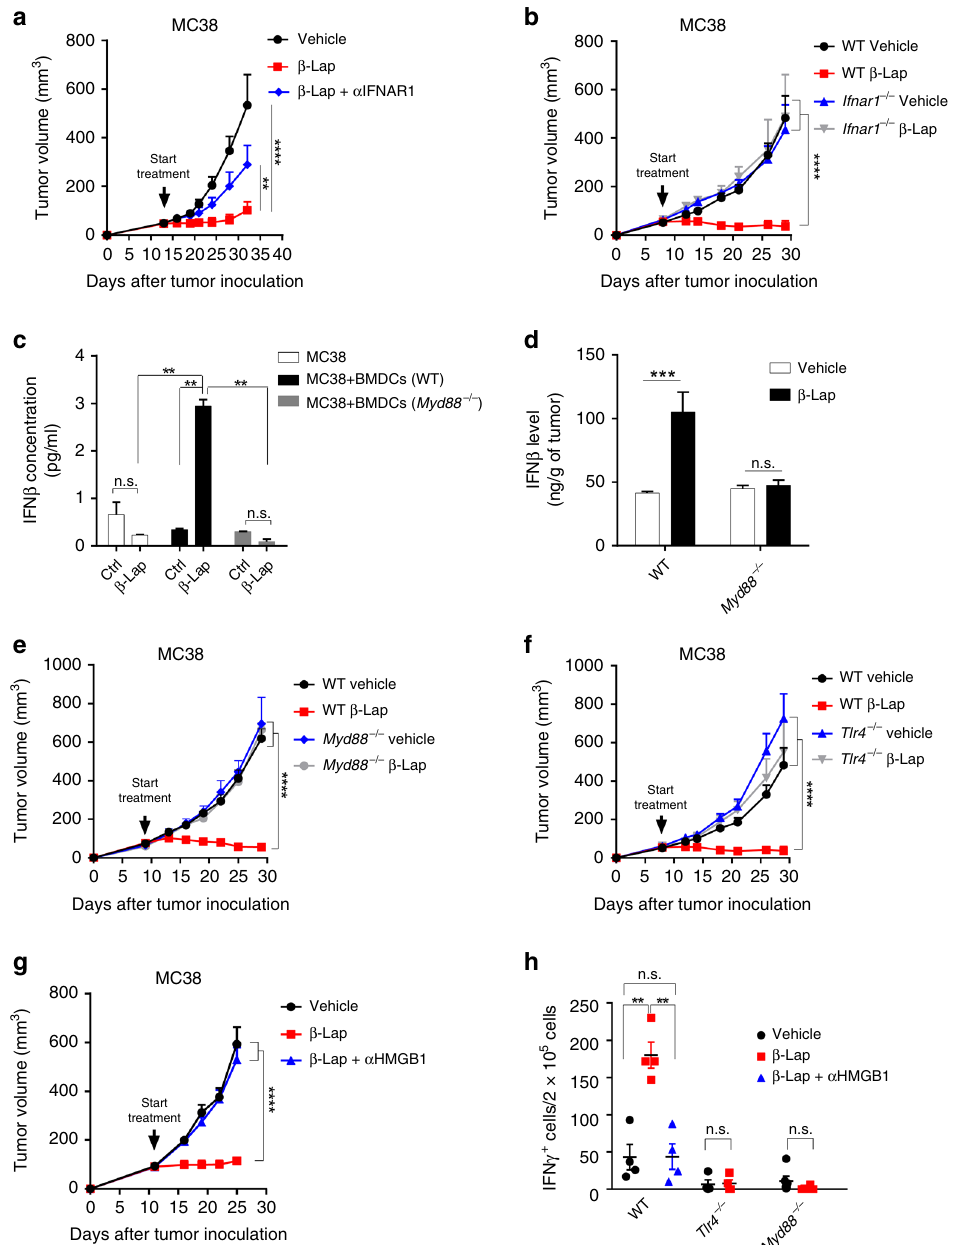
Fig. 4 Type I IFNs and TLR4/MyD88/ signaling are required for the antitumor effect of β -lap. a C57BL/6 mice ( n = 5/group) were transplanted with MC38 cells and treated with β -lap (15 mg/kg, i.t.) every other day for four times. Anti-IFNAR blocking antibodies (150 μ g, i.t.) were administrated every four days for three times during the treatment. b The MC38 tumor-bearing WT ( n = 5/group) and Ifn α r1 − / − ( n = 4/group) C57BL/6 mice were treated with β -lap. c MC38 cells were treated with β -lap (4 μ M) for 3 h followed by washing and replacing fresh medium. Twenty-four hours later, BMDCs from WT or Myd88 − / − mice were co-cultured with β -lap-treated tumor cells for another 48 h. The level of IFN β from the culture supernatant was detected by ELISA. d WT and Myd88 − / − ( n = 4/group) C57BL/6 mice were transplanted with MC38 cells and treated with β -lap. Four days later, tumor tissues were collected for protein extraction, and level of IFN β was measured by ELISA. e WT ( n = 5/group) and Myd88 − / − ( n = 3/group) C57BL/6 mice were transplanted with MC38 cells and treated with β -lap. f WT ( n = 5/group) and Tlr4 − / − ( n = 4/group) C57BL/6 mice were transplanted with MC38 cells and treated with β -lap. g C57BL/6 mice ( n = 5/group) were transplanted with MC38 cells and treated with β -lap (15 mg/kg, i.t.) every other day for four times. Anti-HMGB1 neutralized antibody (200 μ g, i.p) was administrated every 3 days for three times during the treatment. h MC38 tumor-bearing WT ( n = 4/group) or Tlr4 − / − ( n = 4/group) or Myd88 − / − ( n = 6/group) C57BL/6 mice were treated with β -lap. Anti-HMGB1 neutralized antibody (200 μ g, i. p) was administrated every 3 days for three times during the treatment. Twelve days after the initial treatment, lymphocytes from the tumor drain lymph nodes were isolated and stimulated with MC38 tumor cells irradiated with 60 Gy. IFN γ -producing cells were determined by ELISPOTs assay. Data are shown as mean ± SEM from three independent experiments. * p < 0.05, ** p < 0.01, *** p < 0.001, **** p < 0.0001 determined by two-way ANOVA